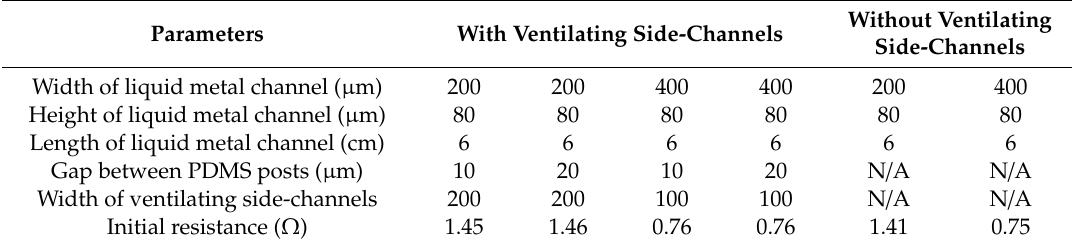
Table 1. Dimensions of microheaters with and without parallel ventilating side-channels. Parameters With Ventilating